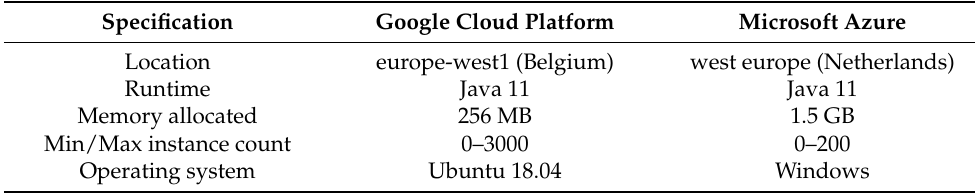
Table 1. Function execution environment